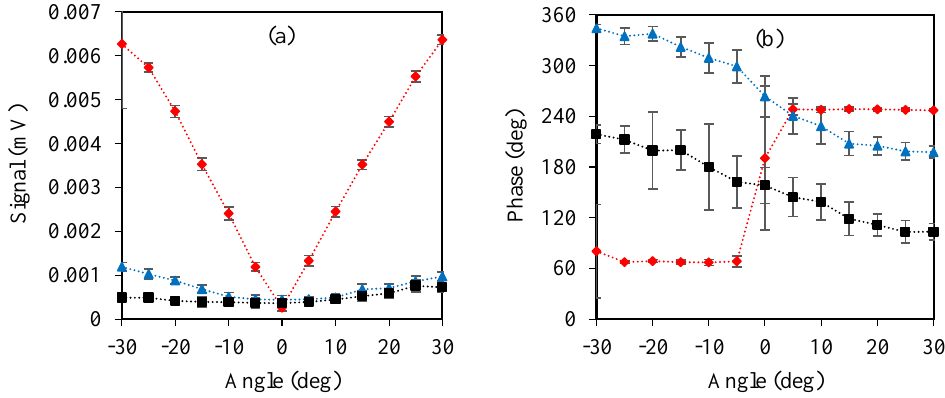
Figure 3. Amplitude ( a ) and phase ( b ) of the rf signal as a function of the angle between the normal to the object surface and the sensor axis recorded for a copper (red diamonds), steel (blue triangles), and ferrite (black squares) plate. Lines connecting points serve only to guide the eye. The measurement was performed at an operating frequency of 6 kHz. The primary rf field coil is located above the centre of the